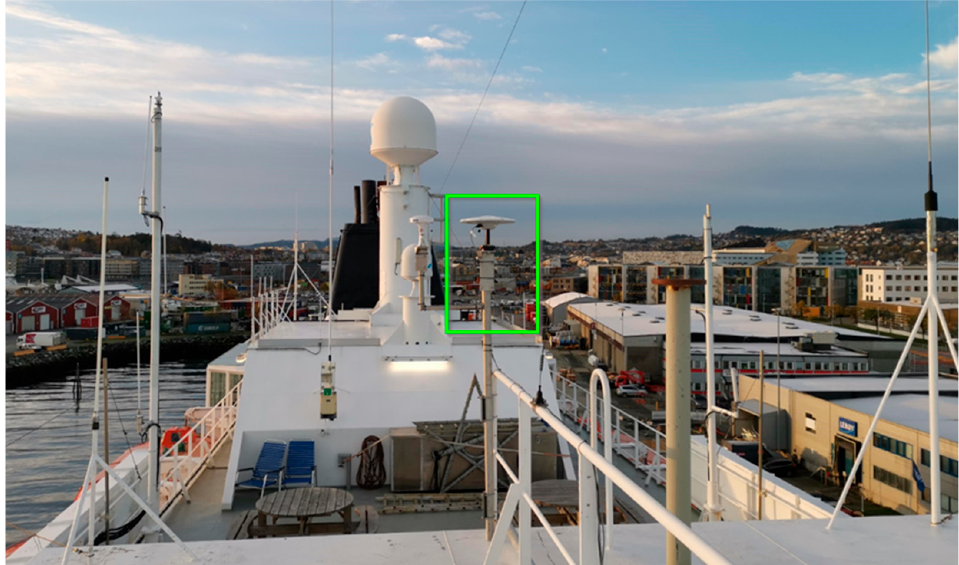
Figure 2. GNSS antenna mounted on board the Hurtigruten vessel sailing from Bergen to Kirkenes. This setup allowed the collection of GNSS data at very high latitudes. A total of 50 this paper.